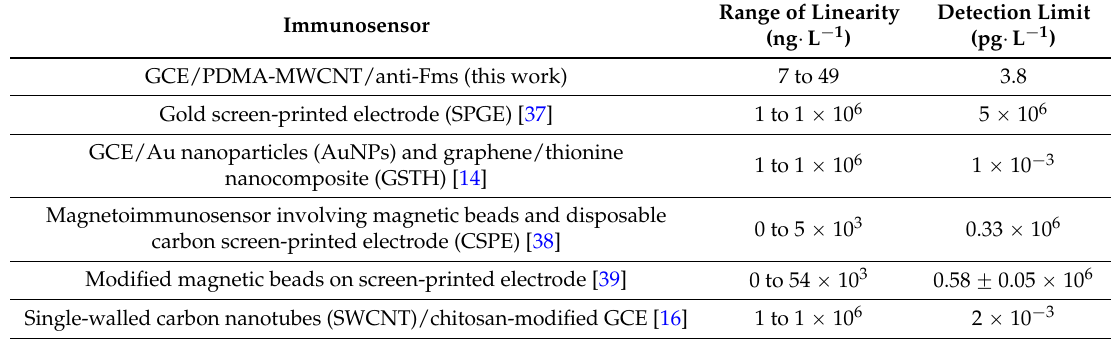
Table 2. Characteristics of the GCE/PDMA-MWCNT immunosensor along with those reported in the literature for fumonisin B 1 detection.